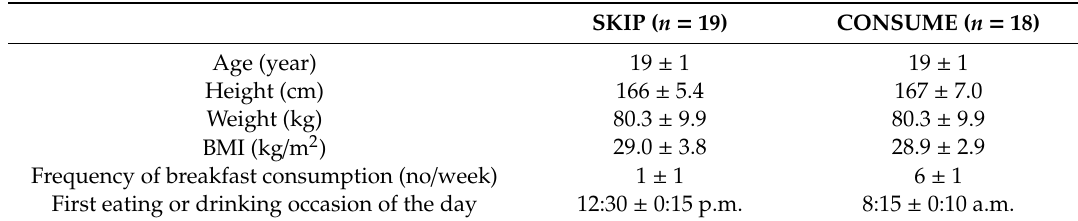
Table 1. Participant characteristics for habitual breakfast skippers (SKIP) and consumers (CONSUME). Data are reported as means ± SD (when